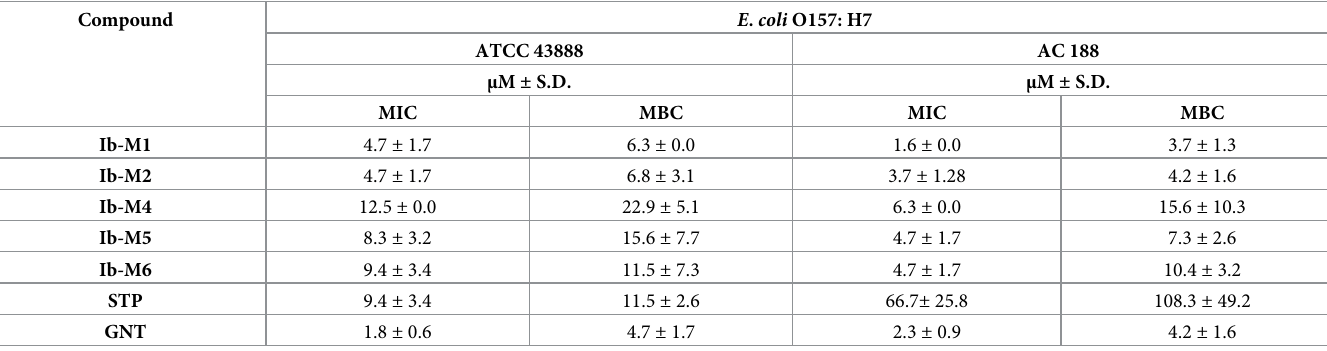
Table 2. Minimum inhibitory concentration (MIC) and minimum bactericidal concentration (MBC) of Ib-M peptides against E . coli O157: H7. Compound E . coli O157: